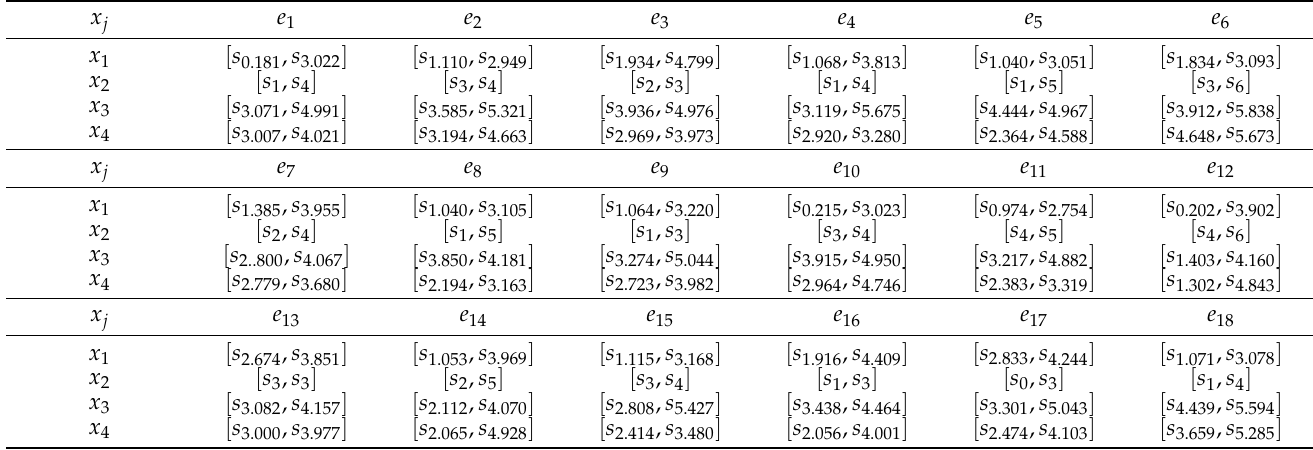
Table 7 shows the opinions in the second round with Formula (22). Table 7. The second-round decision information of decision makers about